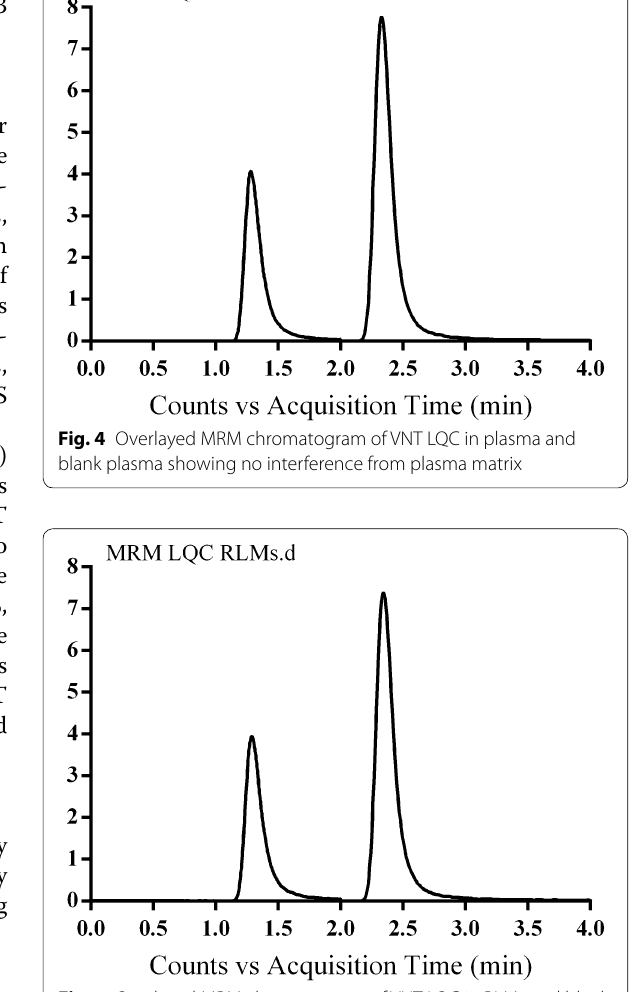
Fig. 5 Overlayed MRM chromatogram of VNT LQC in RLMs and blank RLMs showing no interference from RLMs